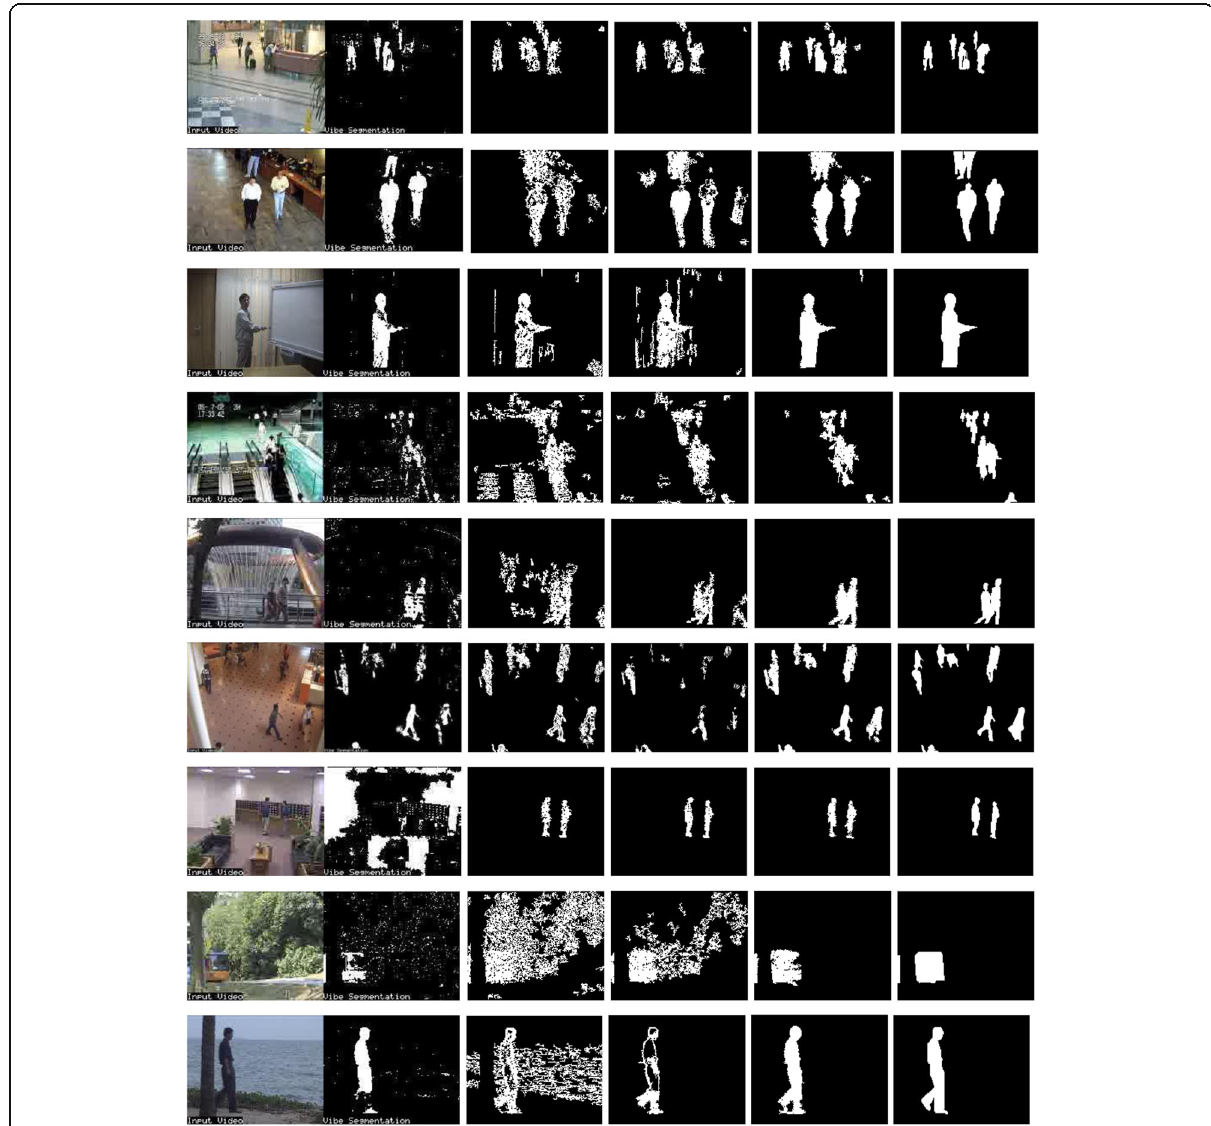
Fig. 11 Background subtraction results on the Star dataset — original image frames (first column), results obtained by ViBe (second column), results obtained by SILTP (third column), results obtained by MC-SILTP (fourth column), results obtained by our method (fifth column), and ground truths (last